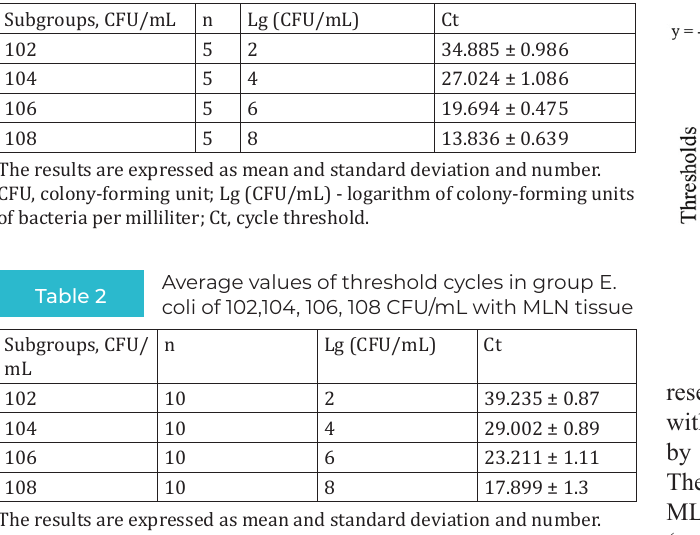
Average values of threshold cycles in the E.coli group of 102, 104, 106,108 CFU/mL in saline